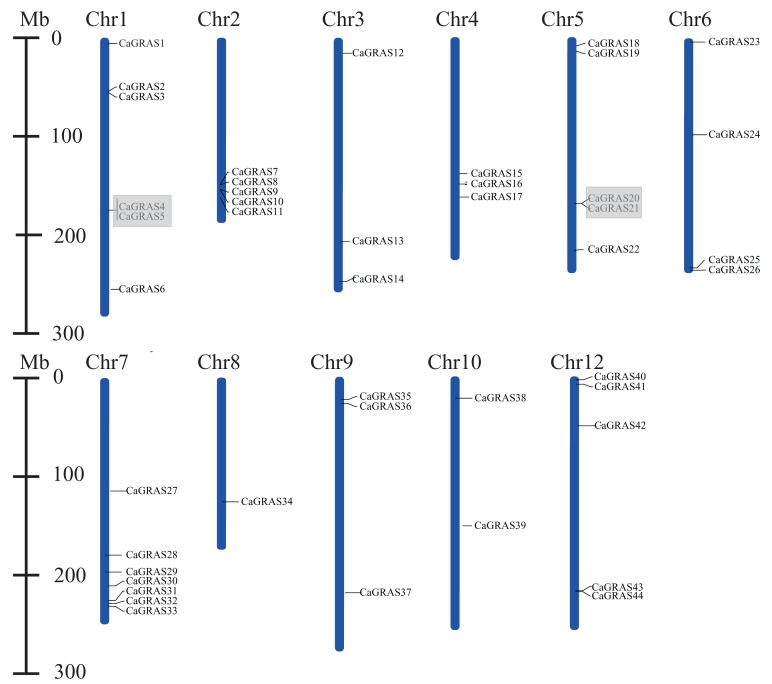
Positions of CaGRAS genes on pepper chromosomes.Gray shading indicates tandem duplicated region.